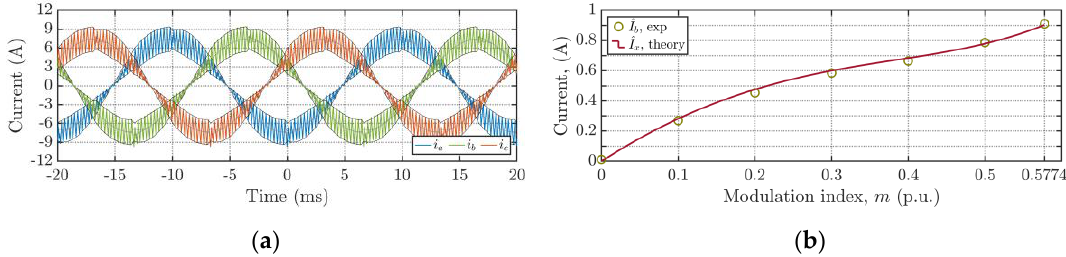
DPWMMIN ( m = 1/√3); ( b ) Phase current ripple rms in case of DPWMMIN.